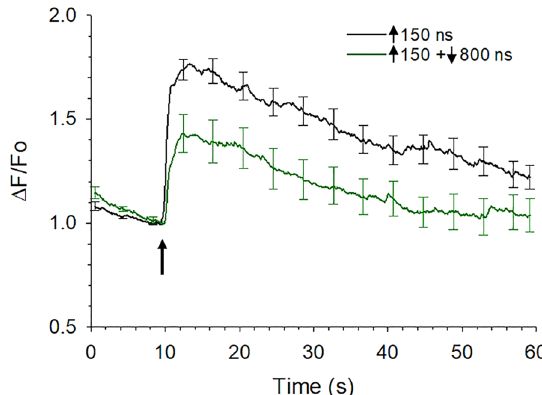
Figure 8. Comparison of the effect of asymmetrical bipolar pulses vs a unipolar pulse on [Ca 2 + ] i when the duration of the negative phase was increased and the amplitude decreased. Averaged cell responses ± s.e.m for cells exposed to a 150 ns unipolar pulse vs a ↑ 150 + ↓ 800 ns pulse (n = 15–10) in which the positive pulse phase was set to 3.1 kV/cm and negative pulse phase set at 0.2 kV/cm. The arrow indicates when the pulse was delivered to the